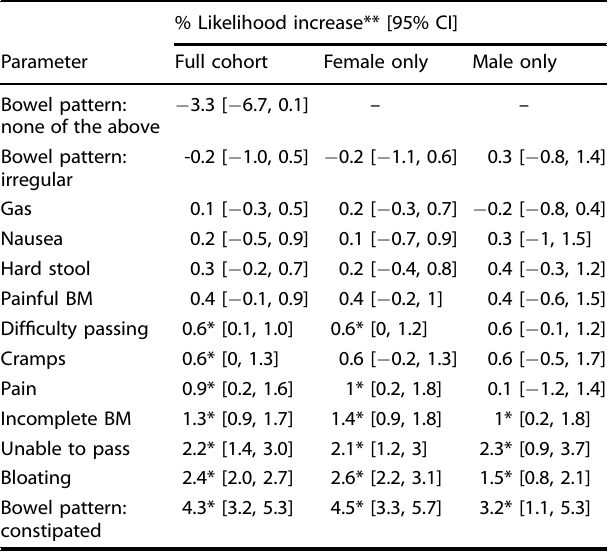
Fig. 3 Boxplots of symptom severity. a A boxplot of symptom severity on self-reported management approach from the monthly surveys. b A boxplot of symptom severity on medication use approach from the monthly surveys. Symptoms scores in each group are on a 0 – 4 scale with 4 as the most severe symptom. Each boxplot shows the median (center line) and inter-quartile range (box bounds) and the largest (top whisker) and smallest (bottom whisker) values within 1.5* interquartile. Only signi fi cant results are shown. Table 4. Estimated percent increase in likelihood of using a constipation